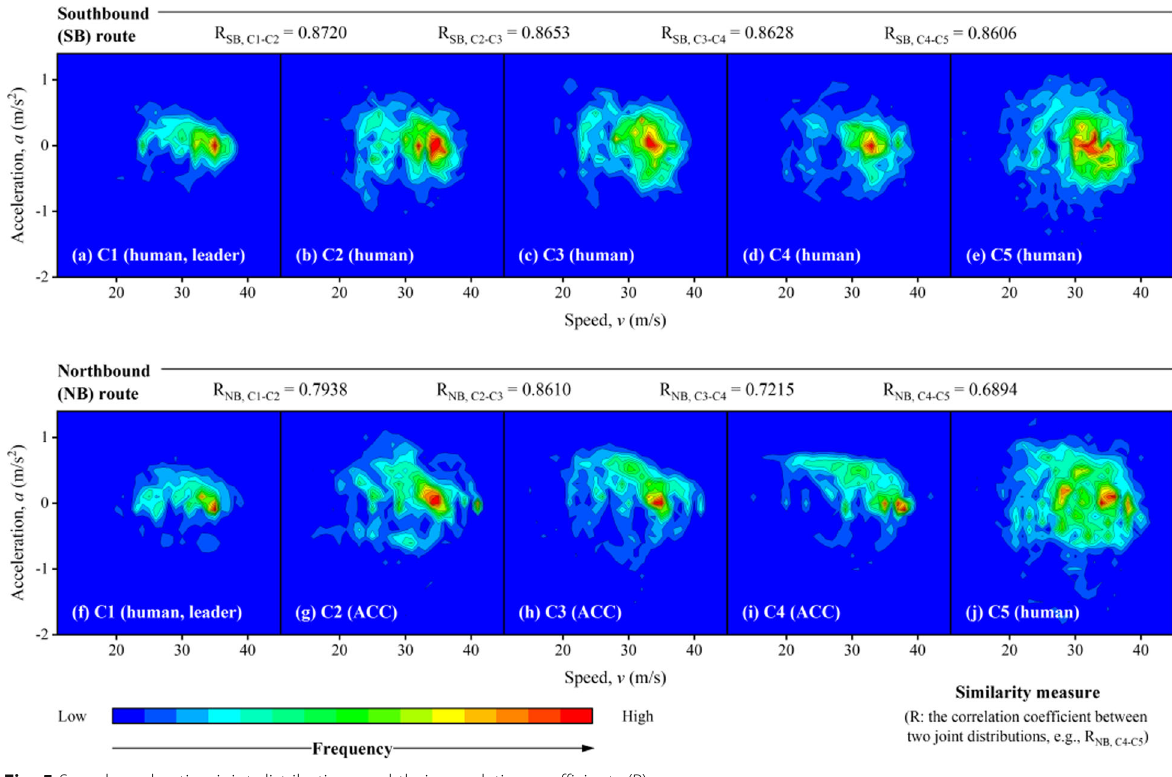
Fig. 5 Speed-acceleration joint distributions and their correlation coefficients